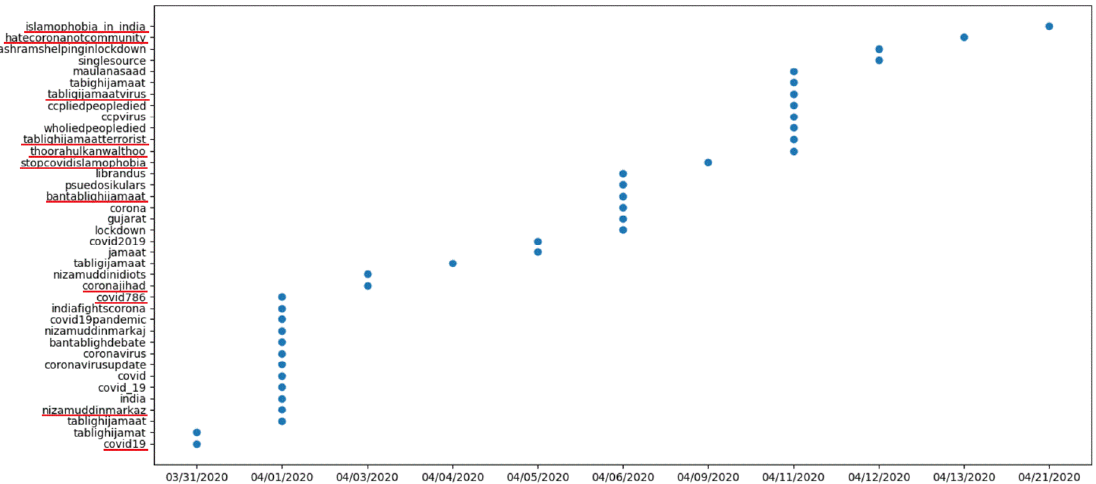
Figure 3. Birth of hashtags.